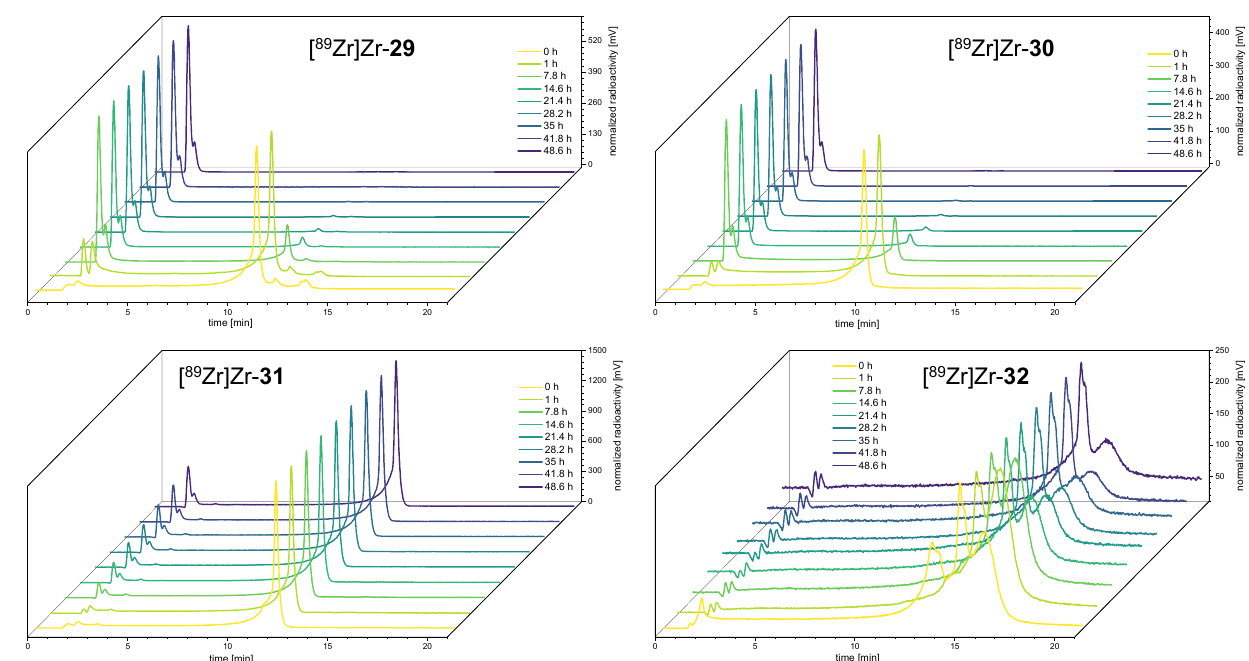
Figure 4. Exemplary analytical radio-HPLC chromatograms over the course of the complex challenge experiments for the different 89 Zr complexes investigated (5 nmol of each 89 Zr complex ([ 89 Zr]Zr- 29 –[ 89 Zr]Zr- 32 ) were incubated with 50 µmol of EDTA, and the transfer of 89 Zr to EDTA was monitored over 48 h).